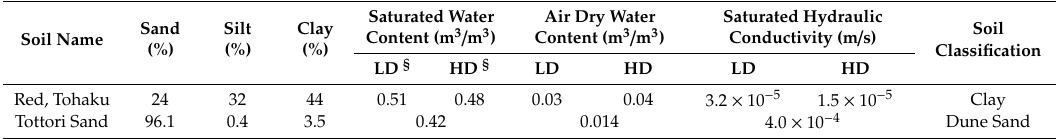
Table 1. Physical properties of soils used in this